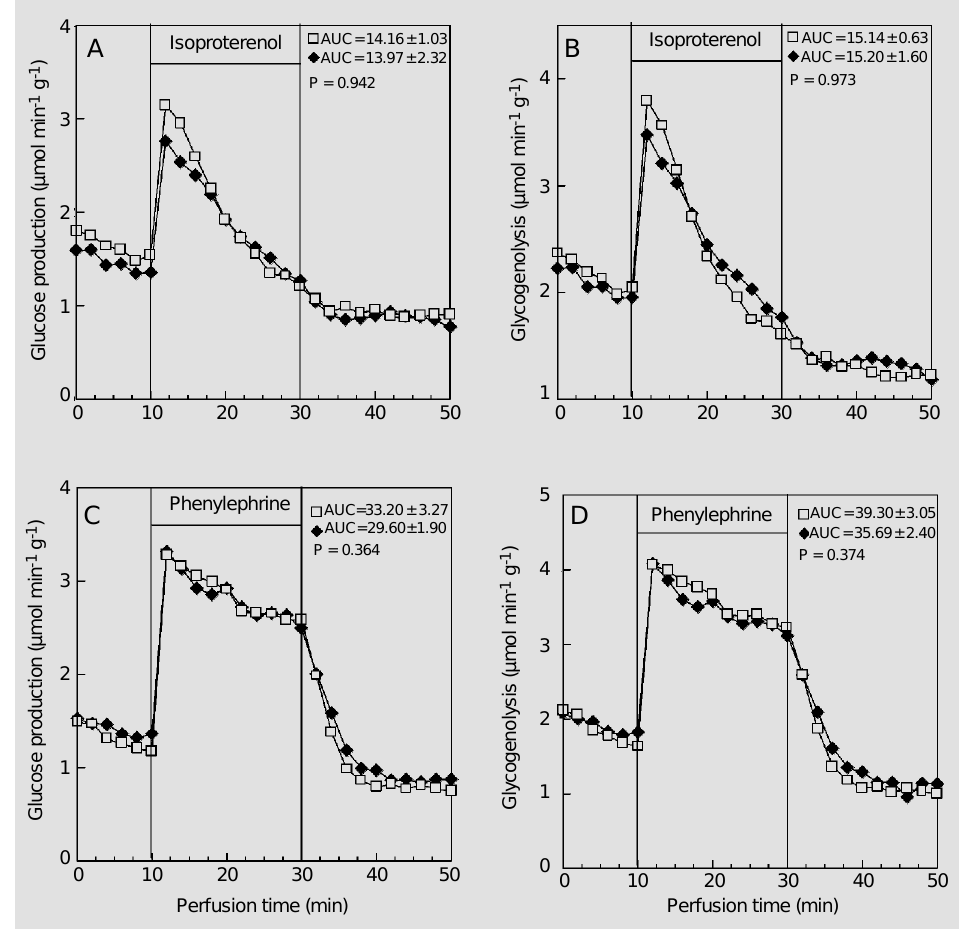
Figure 3 - Effect of isoproterenol (20 µM; panels A and B) and phenylephrine (2 µM; panels C and D) on glucose production and glycogenolysis. The data re- ported are the mean of 5 indi- vidual liver perfusion experi- ments performed 120 min after injection of saline (CN group, squares) or insulin (IN group, dia- monds). The livers were per- fused as described in Material and Methods. The IN group rep- resents recovered animals, i.e., rats that showed normoglyce- mia after 120 min of insulin ad- ministration. AUC = Area under the curve. The statistical test used was the unpaired Student t